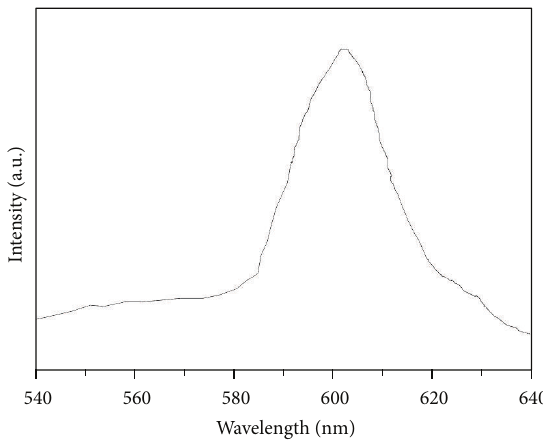
Figure 5: UV-Vis spectra of the as-synthesized SmVO 4 nanocrystals under 180 ∘ C, with different pH values: (a) EDTA, pH = 4; (b) EDTA, pH = 6; (c) EDTA, pH = 8; (d) EDTA, pH = 10.